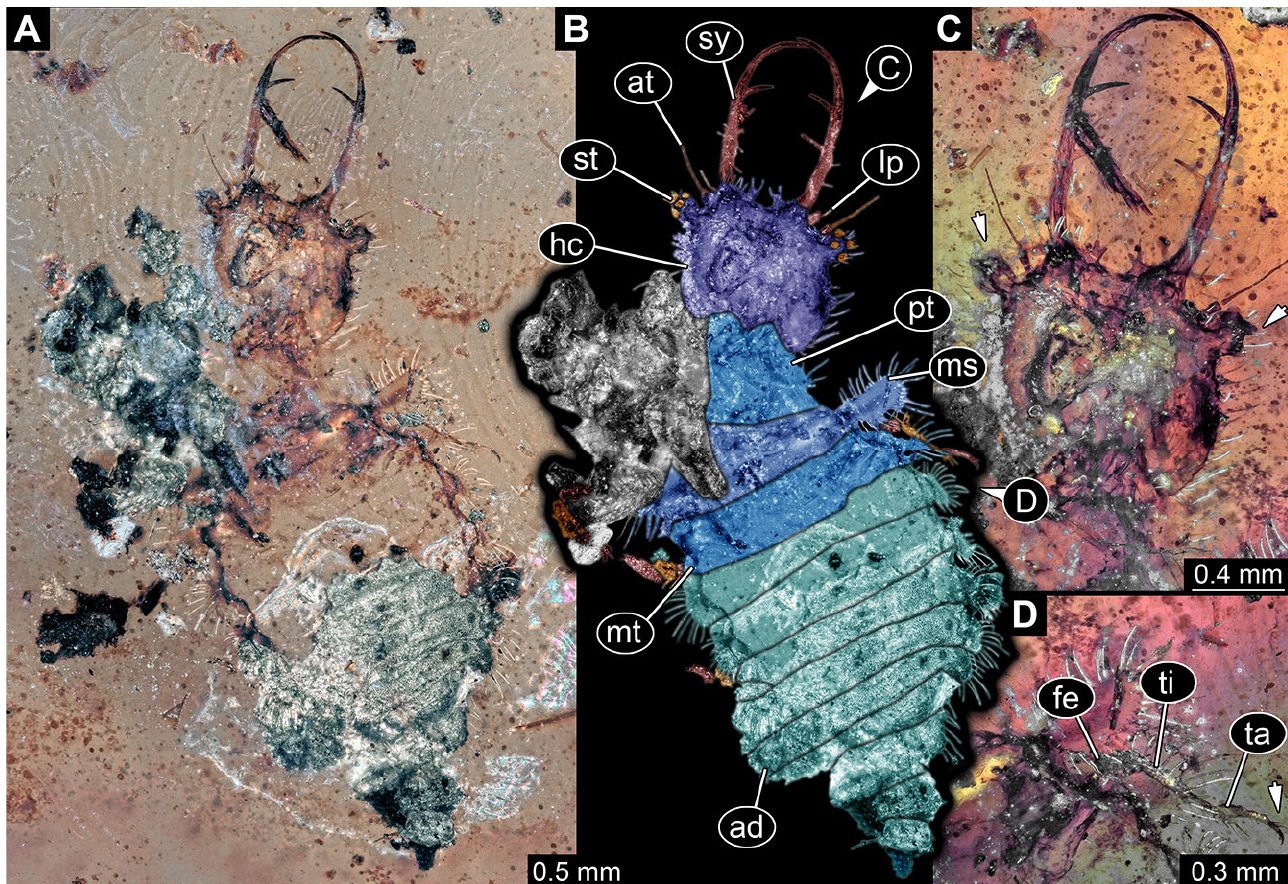
Figure 34. Fossil owllion larva, specimen 3247 (PED 1047), Cretaceous Kachin amber, Myanmar. ( A ) Overview, dorsal. ( B ) Color-marked version of ( A ). ( C ) Close-up on head capsule with fields of stemmata (arrows). ( D ) Close-up on trunk with locomotory appendages with claws (arrow). Abbreviations: ad = abdomen; at = antenna; fe = femur; hc = head capsule; lp = labial palp; ms = mesothorax; mt = metathorax; pt = prothorax; st = stemmata; sy = stylet; ta = tarsus; ti = tibia.